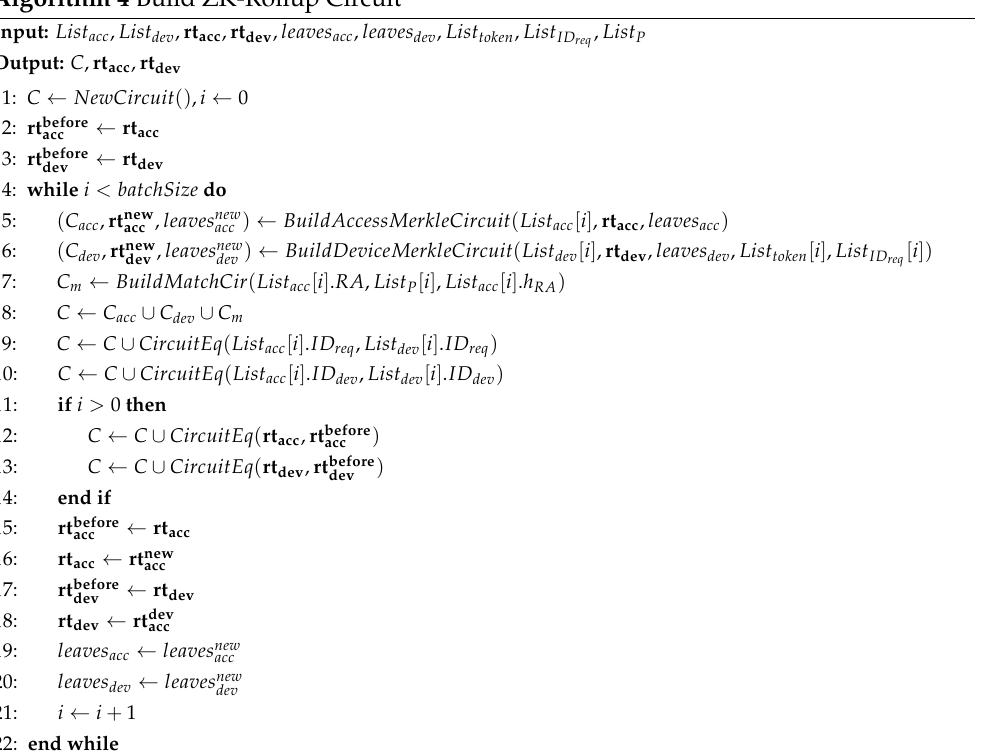
Algorithm 4 Build ZK-Rollup